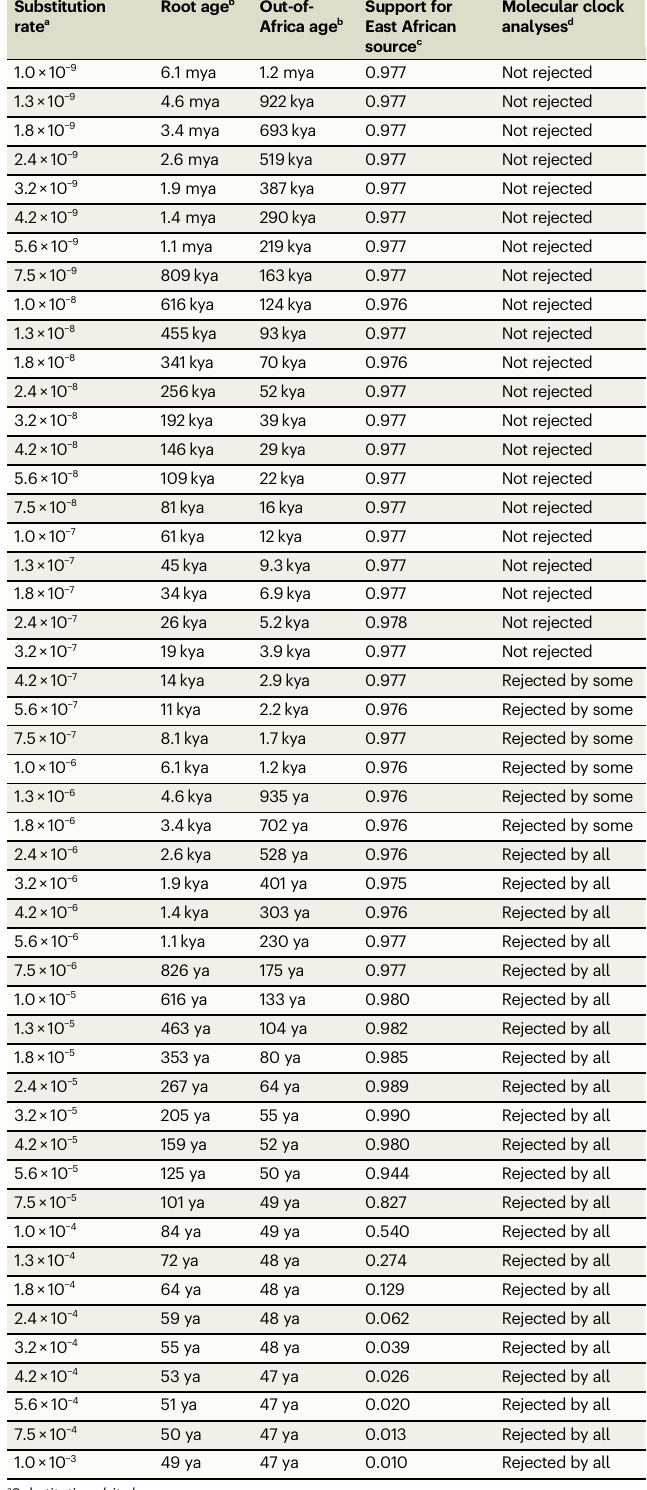
Table 1 | Age of root and out-of-Africa dispersal across clock rates Substitution rate a